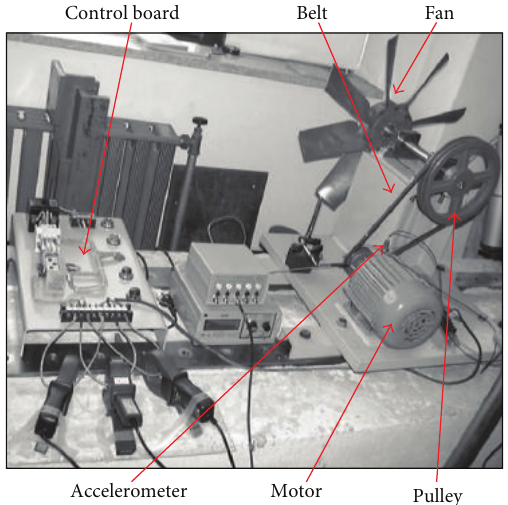
Figure 4: A description of the fault simulation test rig and the